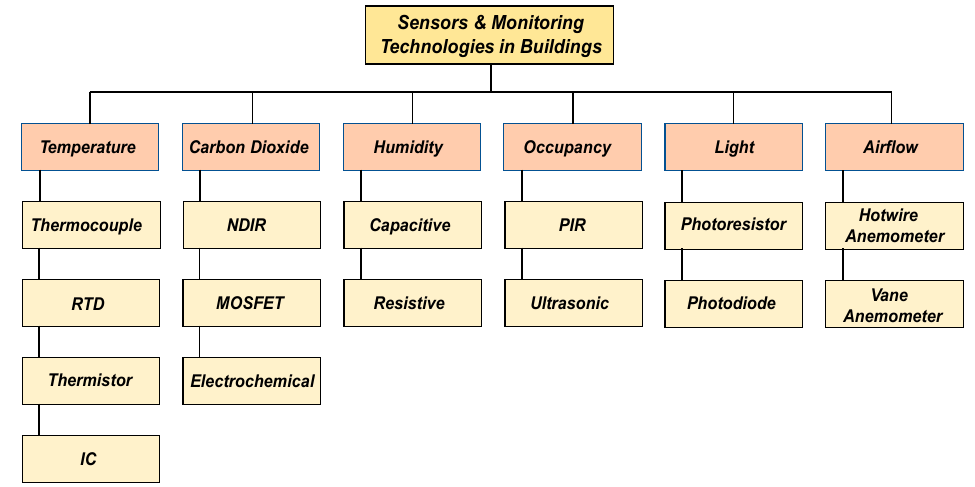
Figure 2. Prominent sensors and monitoring technologies for buildings applications.